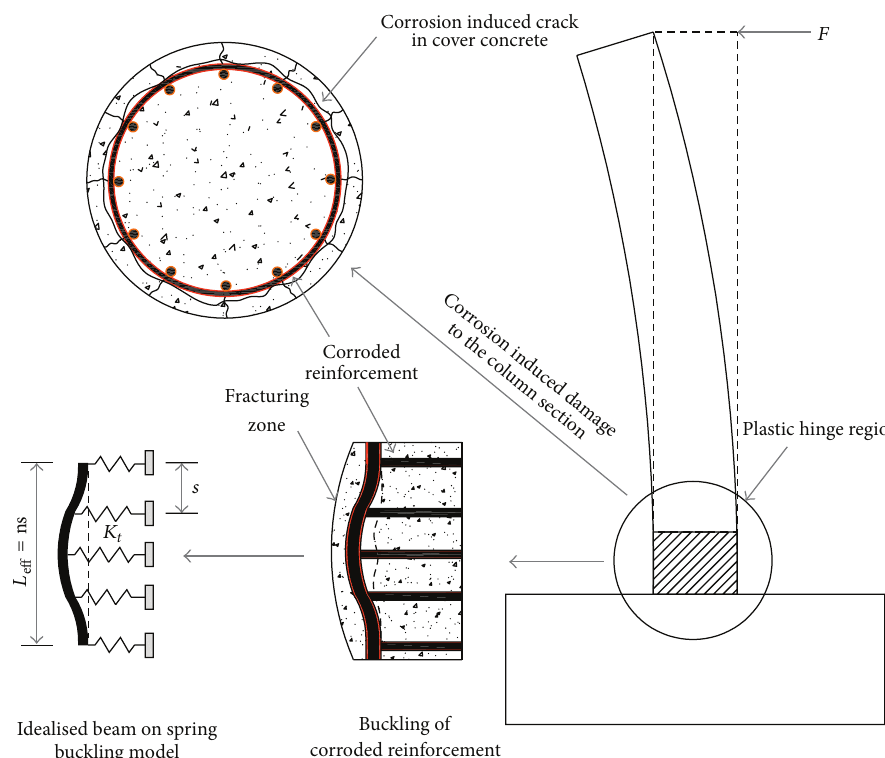
Figure 3: Schematic overview of corrosion induced damage to RC